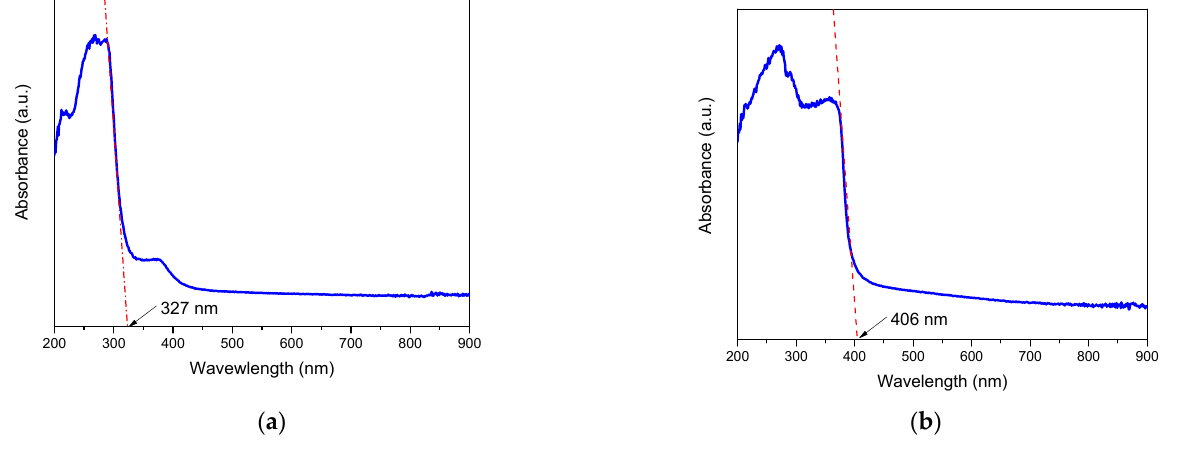
Figure 3. UV–Vis spectra and determination of the bandgap energies: ( a ) ZnO N ; ( b ) ZnO A .